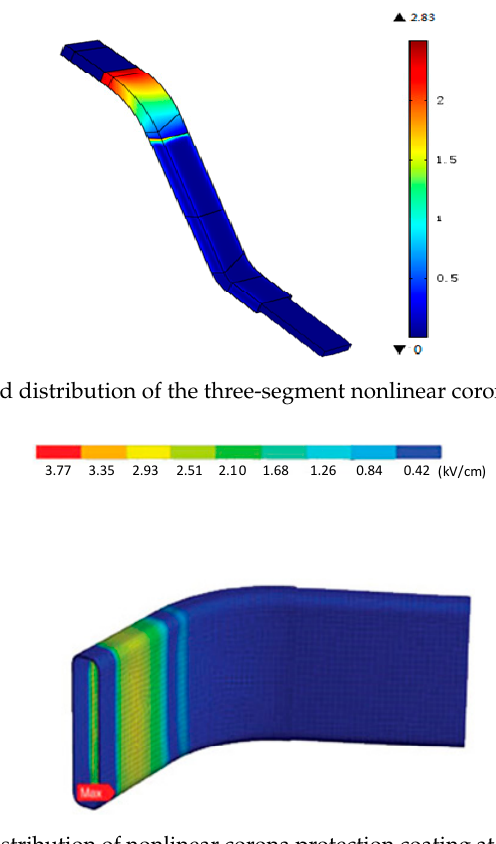
Figure 7. Electric field distribution of nonlinear corona protection coating at rated voltage of 20 kV [28].